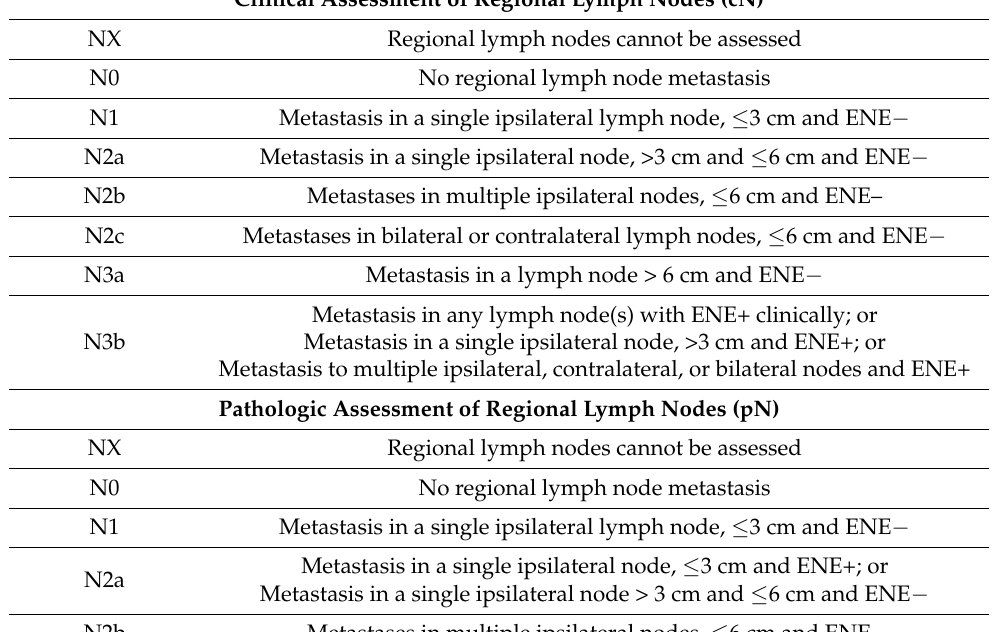
Table 1. Cont. Clinical Assessment of Regional Lymph Nodes